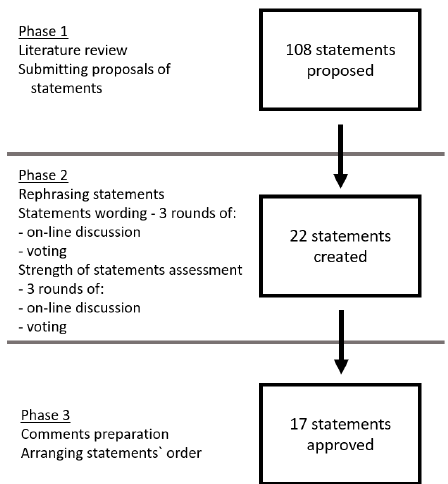
Figure 2. Diagnostics 2020 , 10 , x FOR PEER REVIEW